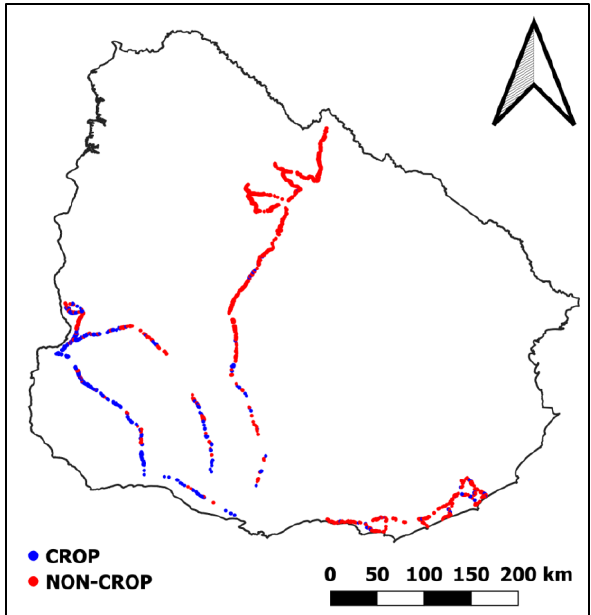
Figure 5. Ground truth points of crop/non-crop.